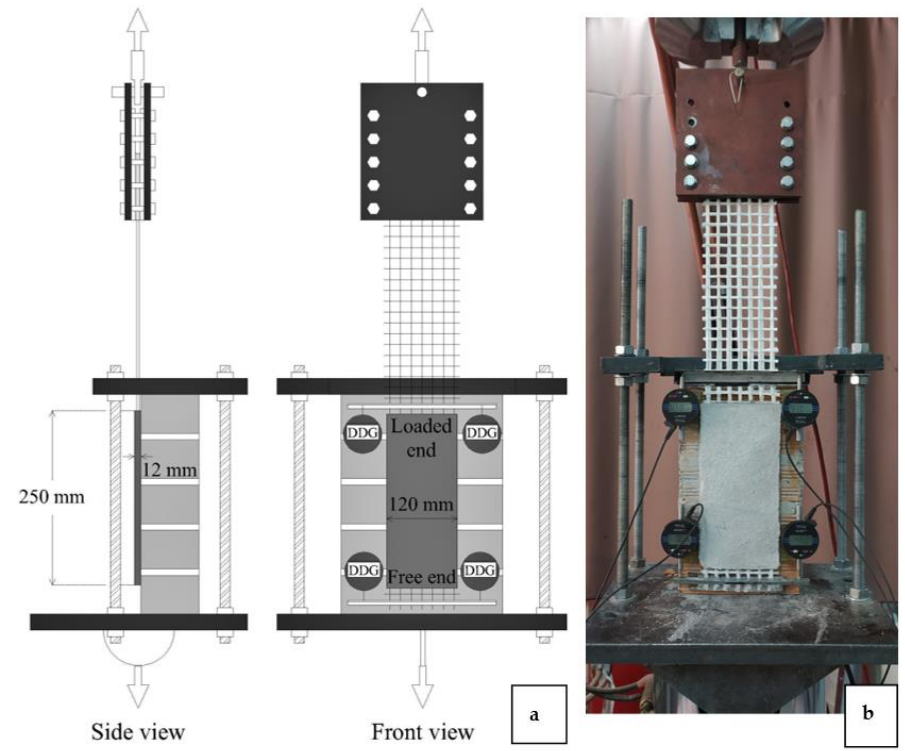
Figure 7. ( a ) A drawing and ( b ) a photo of the SL/SP